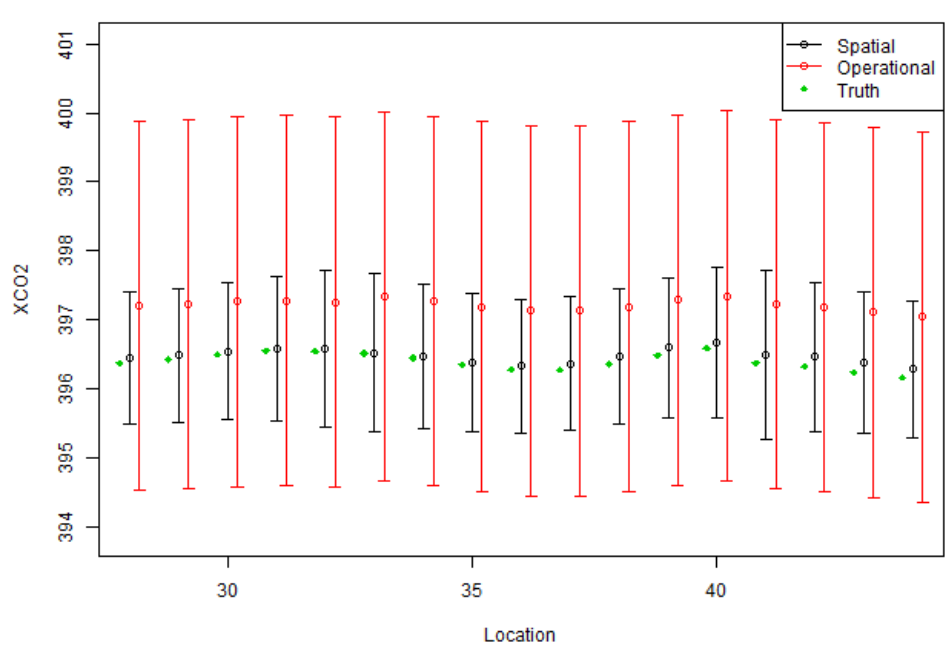
Figure 5. Example of pointwise 95% posterior credible intervals for XCO 64 locations for the October 2015 Lamont template. For spatial retrievals, the posterior intervals were narrower and centered closer to the true XCO